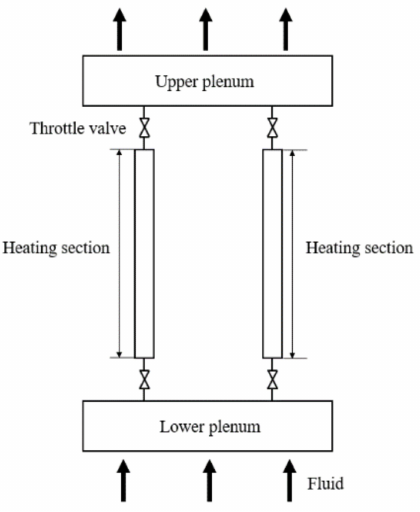
Figure 6. Schematic of the parallel channels model. The homogeneous flow model is adopted, and the corresponding governing equations